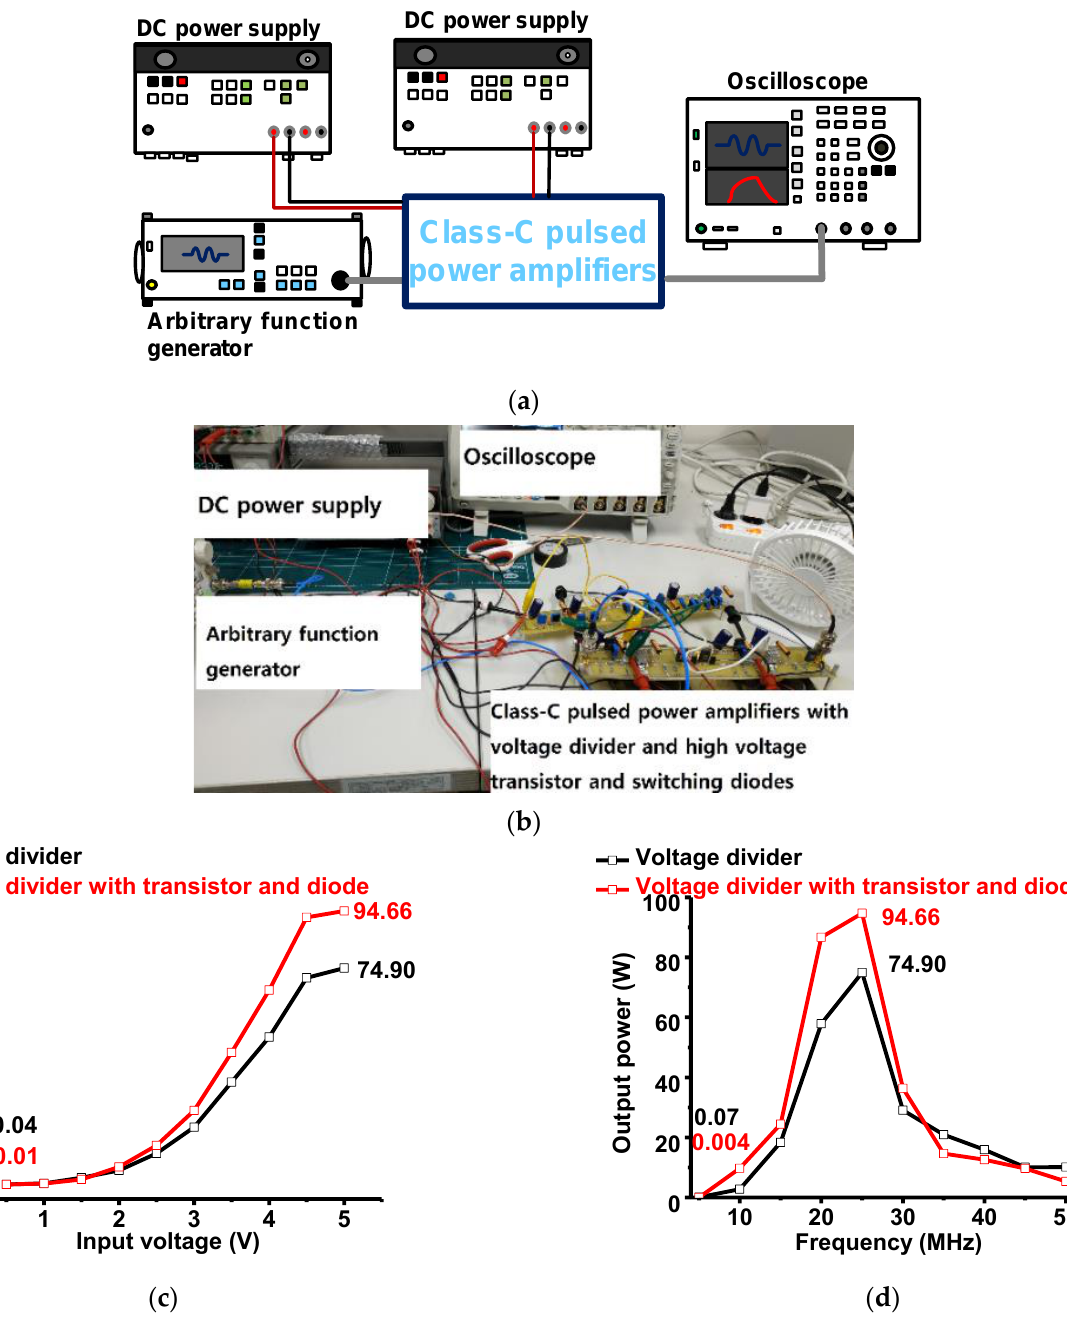
Figure 6. ( a ) Measurement setup and ( b ) photograph of the measurement setup for Class-C pulsed power amplifier output power. The output power of a Class-C pulsed power amplifier with only a voltage divider and with voltage divider integrated with a high-voltage transistor and switching diodes versus ( c ) input voltage and ( d ) frequency.